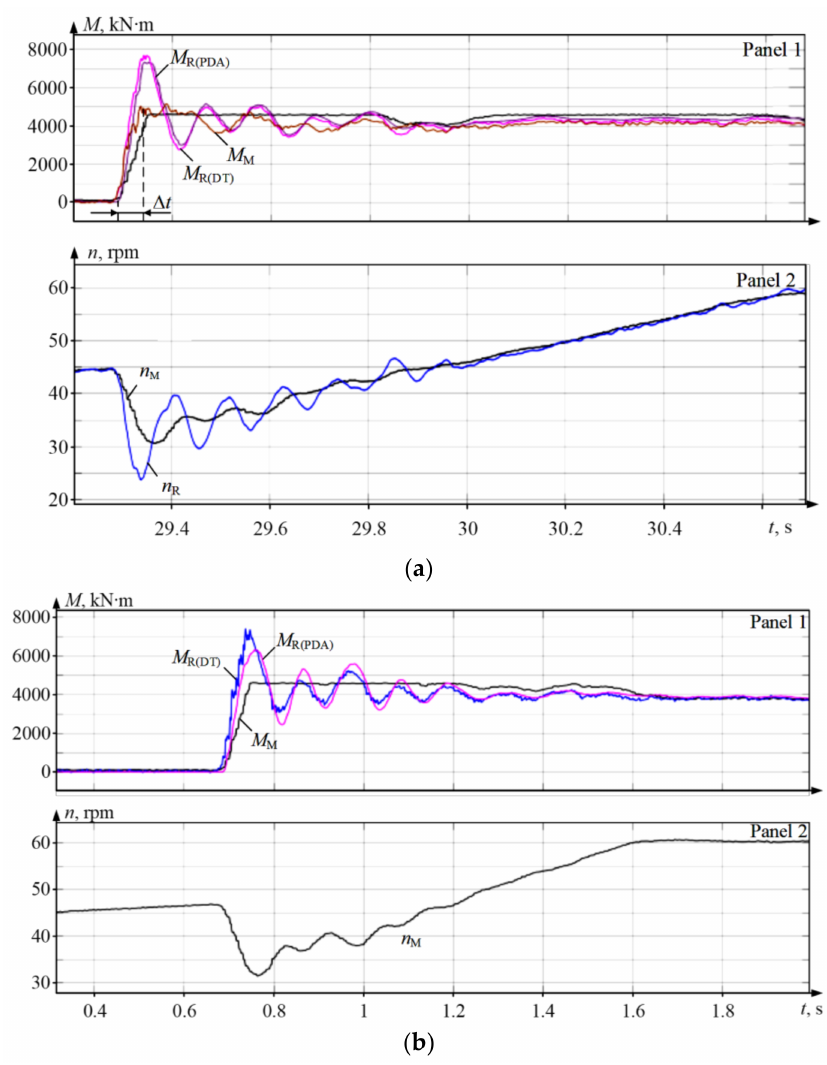
Figure 8. Transients of the measured and reconstructed coordinates in the virtual system ( a ) and in the electric drives of Mill 5000 ( b ), gripping